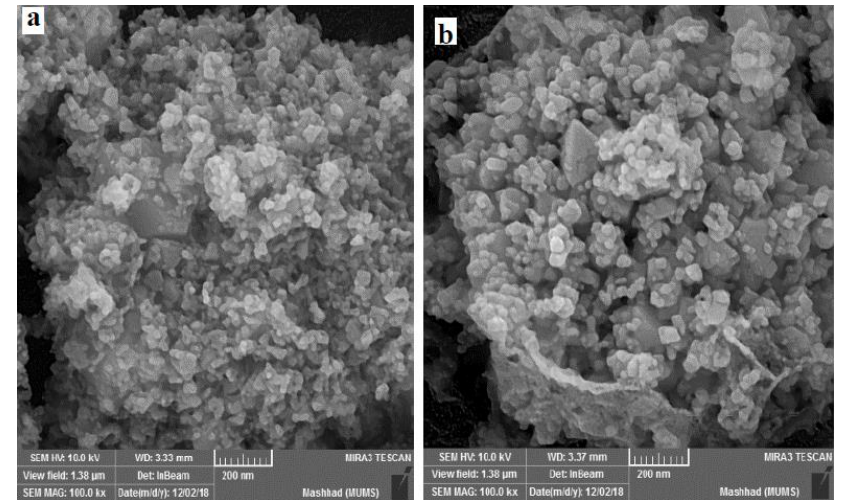
Fig. 2. SEM images of (a) Co Fig 2. SEM images of (a) Co 3 O 4 /NiO, and (b) Co 3 O 4 /NiO@GQDs @SO 3 H